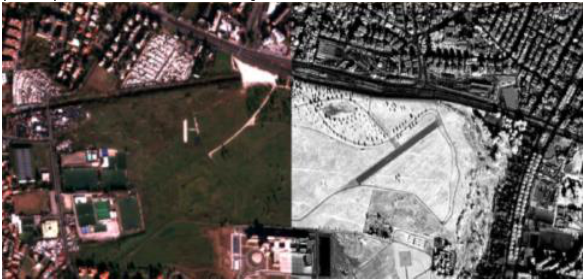
Figure 8. NDVI on a Pleiades image (multispectral), in swipe mode visualization